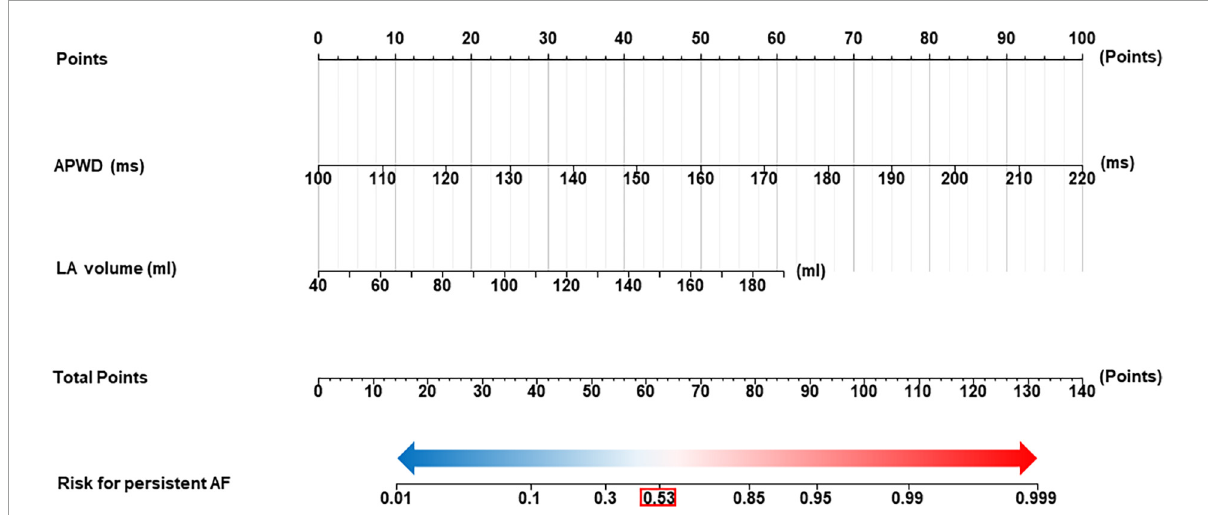
FIGURE9 Nomogram for identification of individuals with persistent AF. The nomogram was developed using integrated model (APWD + LAV) in the training set. The total score of the nomogram for individual is the sum of the corresponding score assigned to each risk factor, and the total score corresponds to the individual risk for persistent AF. The optimal cut-off value for the estimated risk for persistent AF in the nomogram is 0.53 (highlighted by the red box), individuals who are estimated with risk higher than 0.53 are diagnosed as high probability for AF persistency and those below 0.53 as high probability for paroxysmal Af type. LAV, left atrial volume; duration of the amplified digital